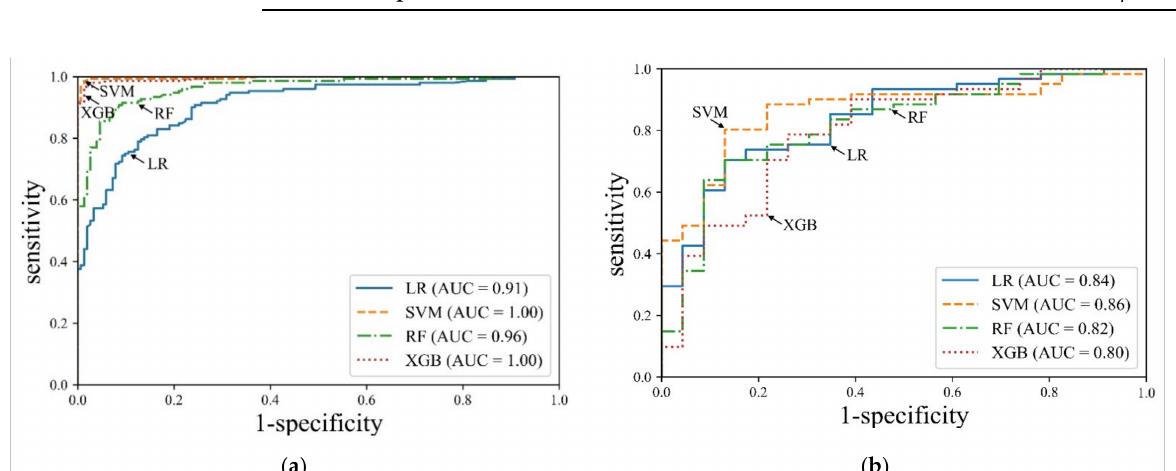
Figure 3. Comparison of receiver operation characteristics between different machine learning models for OSA prediction. The SVM model shows the highest AUC. ( a ) ROC curve obtained with the training data, and ( b ) ROC curve obtained with the test data. LR, logistic regression; SVM, support vector machine; RF, random forest; XGB, XGBoost; OSA, obstructive sleep apnea; AUC, area under the curve; ROC, receiver operating